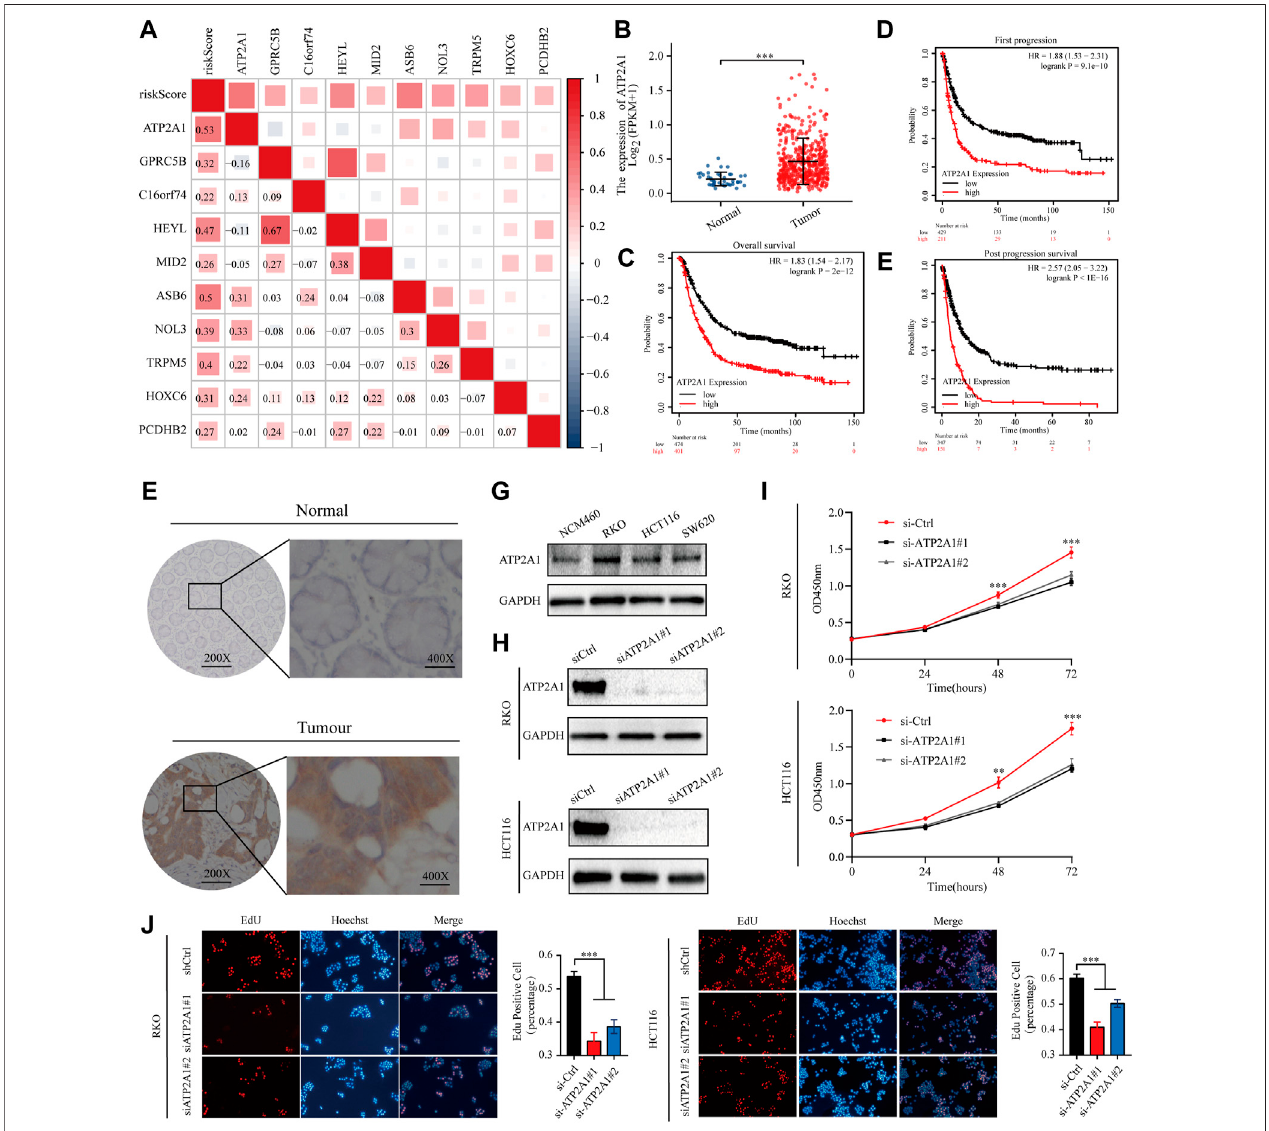
FIGURE5| ATP2A1isrequiredforCRCcellsurvival (A) TherelationshipbetweenATP2A1andriskmodelwasshowedincorrelations matrices (B) Theexpression ofATP2A1inCRCtissuesand adjacentnormaltissueoftheTCGAdatabase (C – E) Kaplan – MeiersurvivalcurvesforCRCpatients basedonATP2A1mRNAexpression (F) Representativeimages ofimmunostainingofATP2A1inprimary CRCsamplesversusnormalsamples (G) RepresentativeimagesofWesternblotofATP2A1inRKO, HCT116, SW620 versus NCM460 (H) Western blot to show knockdown ef fi ciency of ATP2A1 in RKO and HCT116 cells by two independent siRNAs (I) Cell proliferation of RKO cells or HCT116 cells (J) Edu assay to test the cell proliferation of control cells comparing to ATP2A1 knockdown cells.